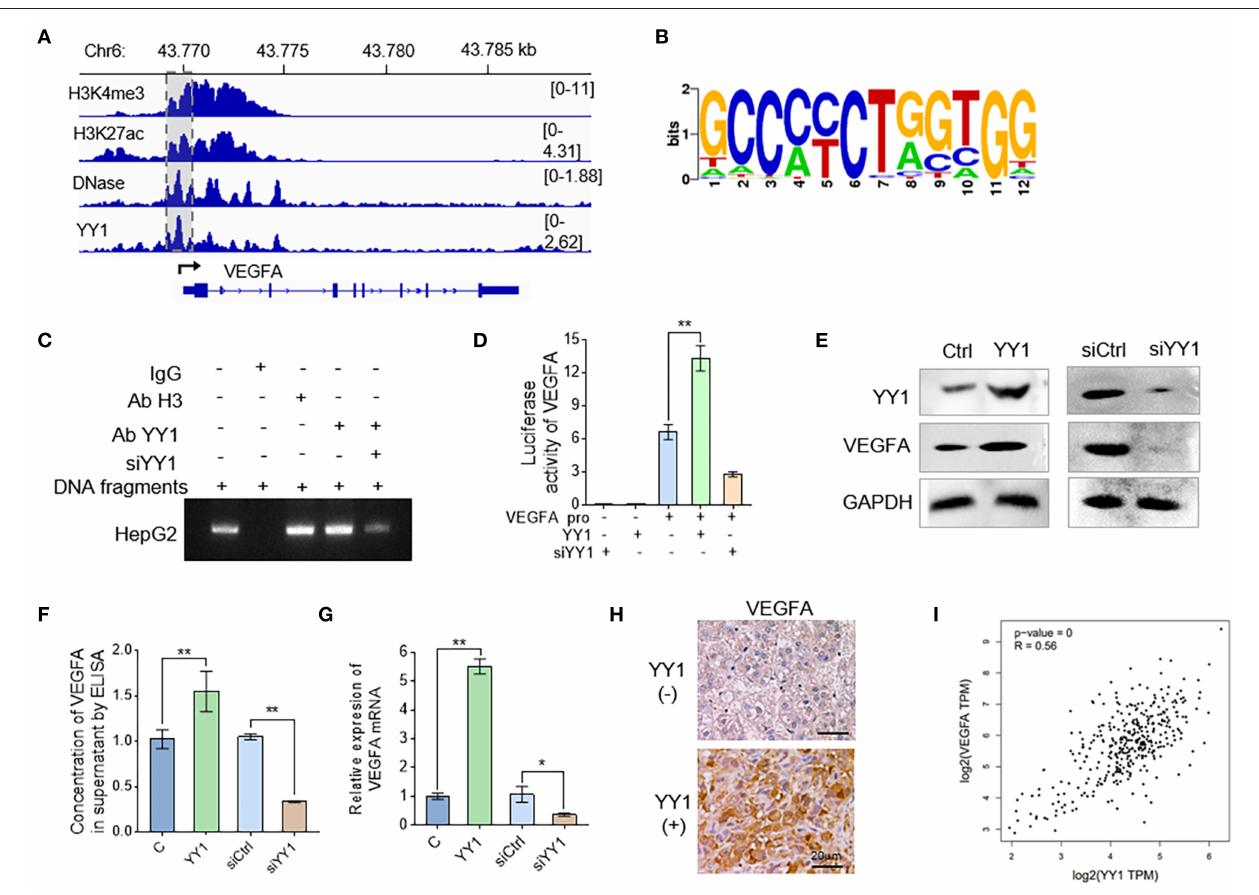
FIGURE 3 | YY1 binds to VEGFA promoter to enhance VEGFA expression in HCC cells. (A) Genomic tracks for ChIP-seq around VEGFA and location of promoter (pink area). (B) Analysis of motifs enriched in YY1 ChIP-seq. (C) HepG2 cells were treated with YY1 overexpression vectors and YY1siRNA. Cellular extracts